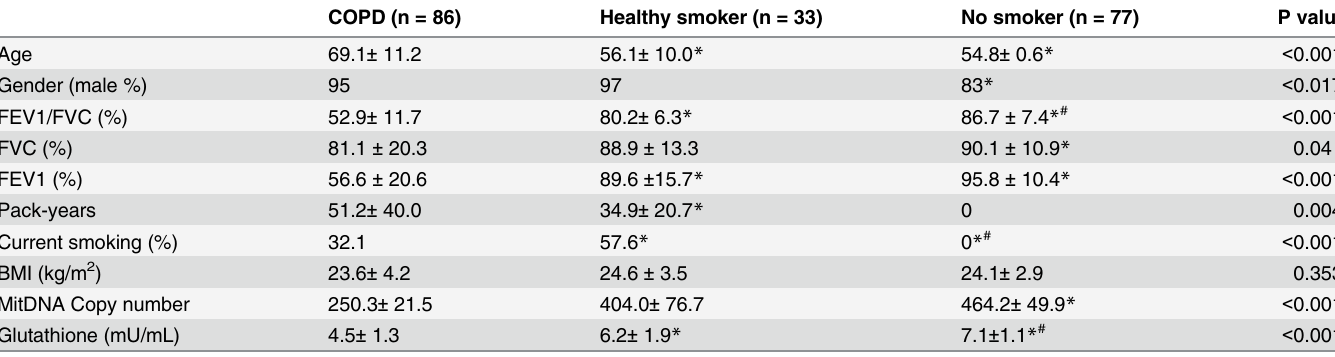
Table 1. Baseline characteristics of COPD group, healthy smoker group and no smokers